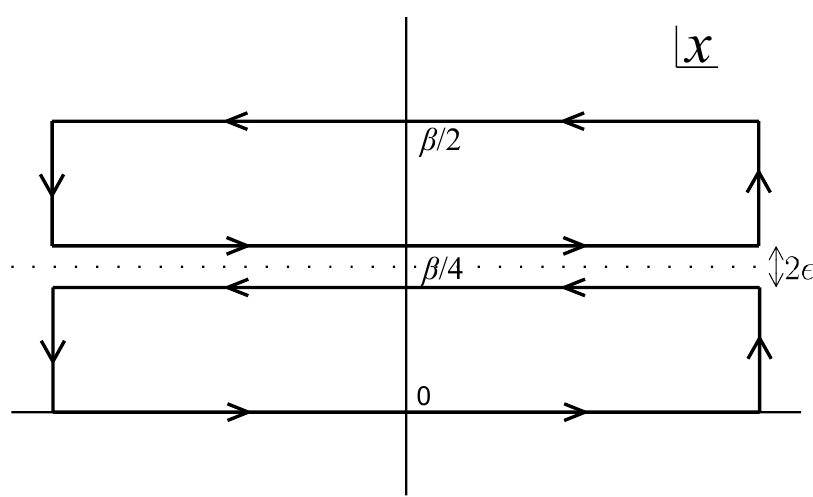
Figure 7 . Contour used when including non-perturbative (cid:11) 0 corrections. The rate of exponential suppression indicates that all singular features are restricted to the line Im ( x ) = (cid:12)= 4. The rectangle is now split in two and, since there are no other poles, the result is given by the discontinuity across the line Im ( x ) = (cid:12)=